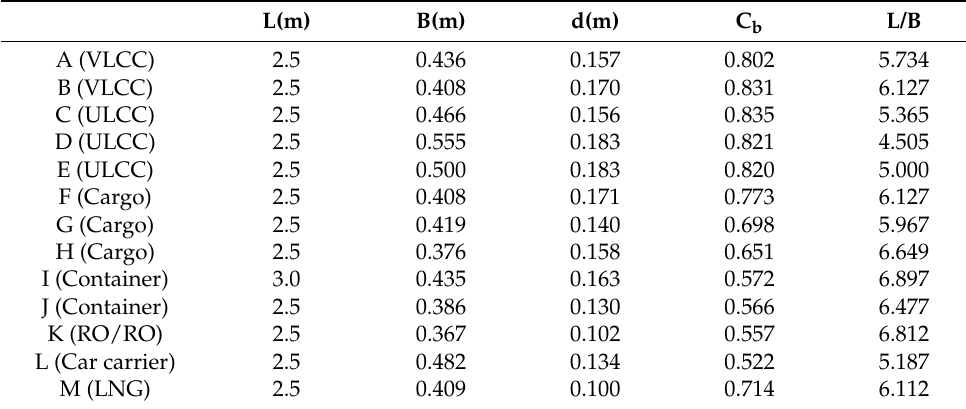
Table 1. Main specifications of model merchant ships (Kijima et al.,